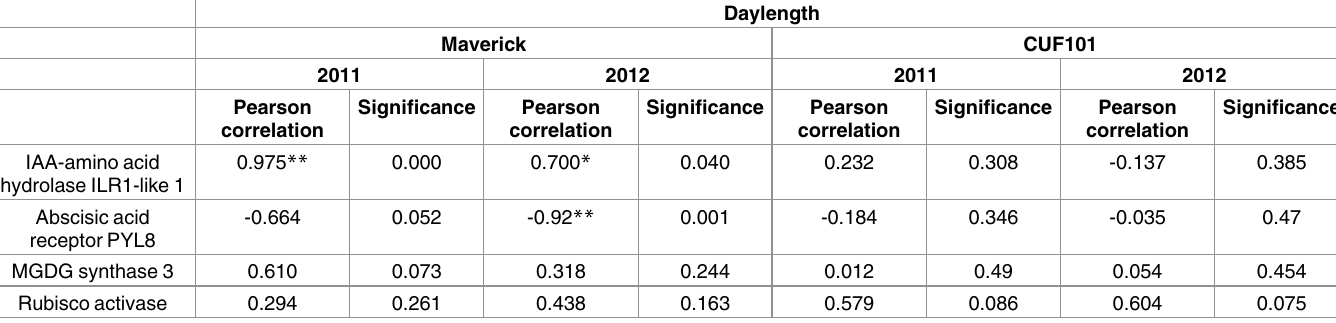
Table 3. Correlation between mRNA abundance in the leavesof Maverickand CUF101varietiesand daylength in 2011 and 2016.